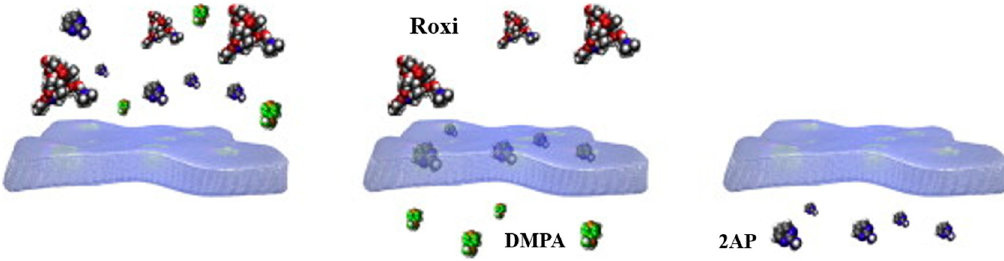
Figure 13. Separation process in nanofiltration MIM: (i) loading the ternary system of roxithromycin (Roxi), 2AP and 4-dimethylaminopyridine (DMAP); (ii) three way separation via retention of Roxi, adsorption of 2AP and permeation of DMAP; (iii) recovery of 2-AP and regeneration of the membrane. Reproduced with permission from [23].